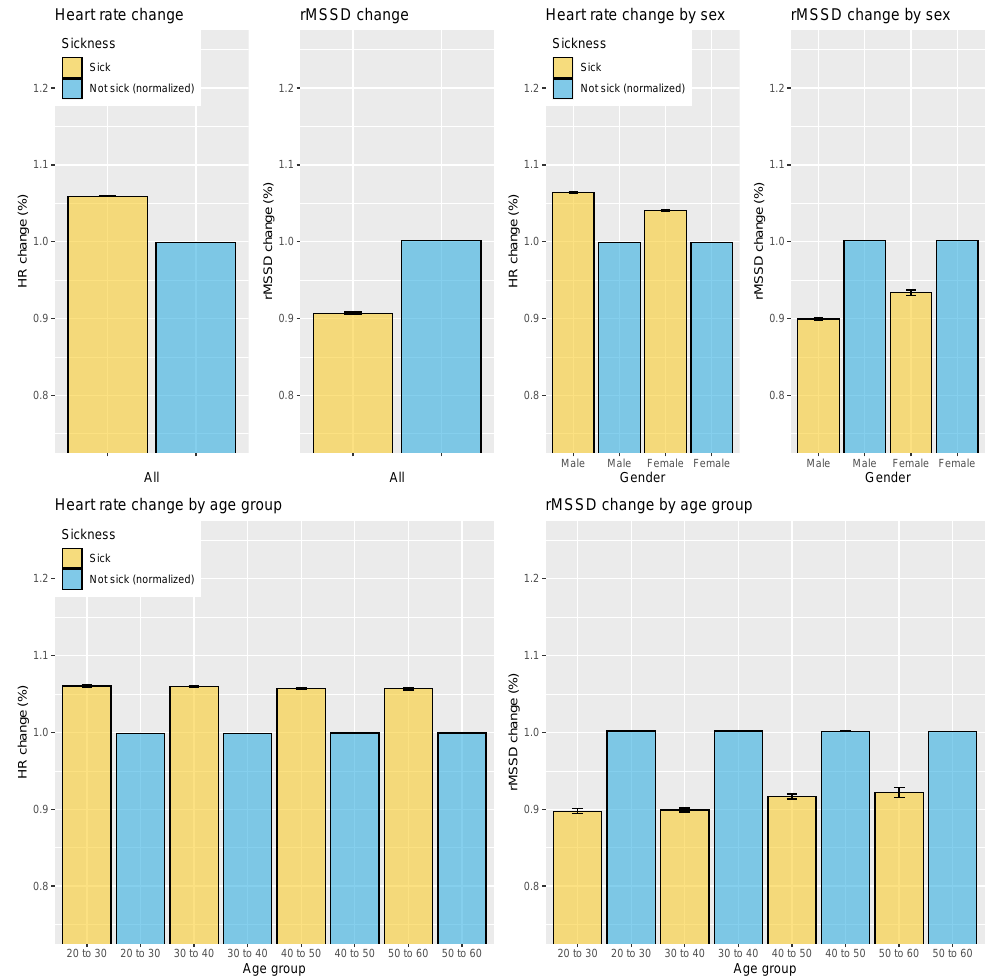
Figure 13. Relation between HR, HRV, and sickness intake on the entire dataset and grouped by sex or age group. HR is consistently increased when sick, while rMSSD is consistently decreased when sick. Additionally, percentage changes in heart rate remain similar across age groups, while they reduce for rMSSD. Error bars indicate the standard